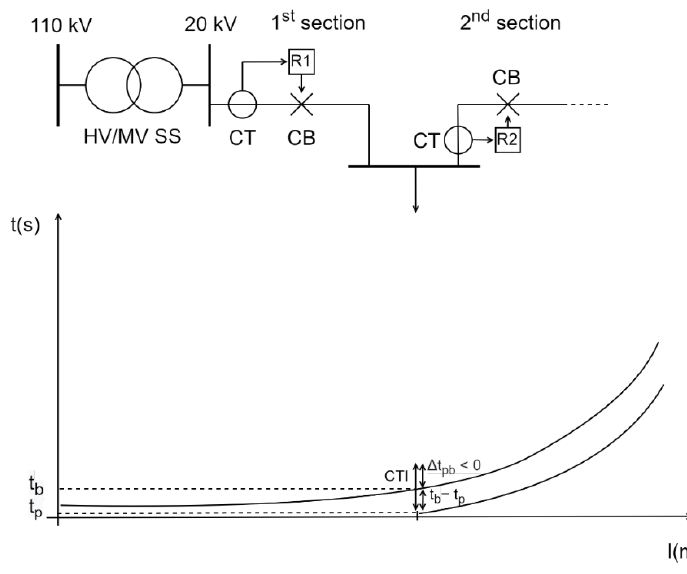
Figure 2. Miscoordination between a primary and backup relay.